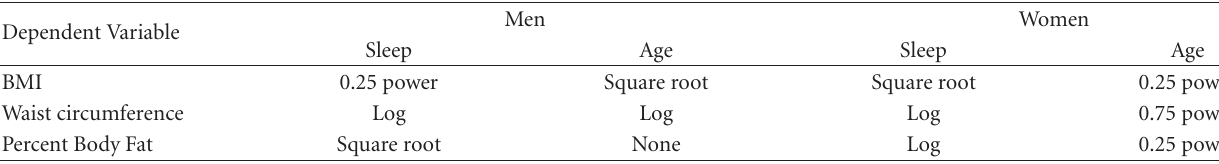
Table 1: Transformations for sleep and age by gender.